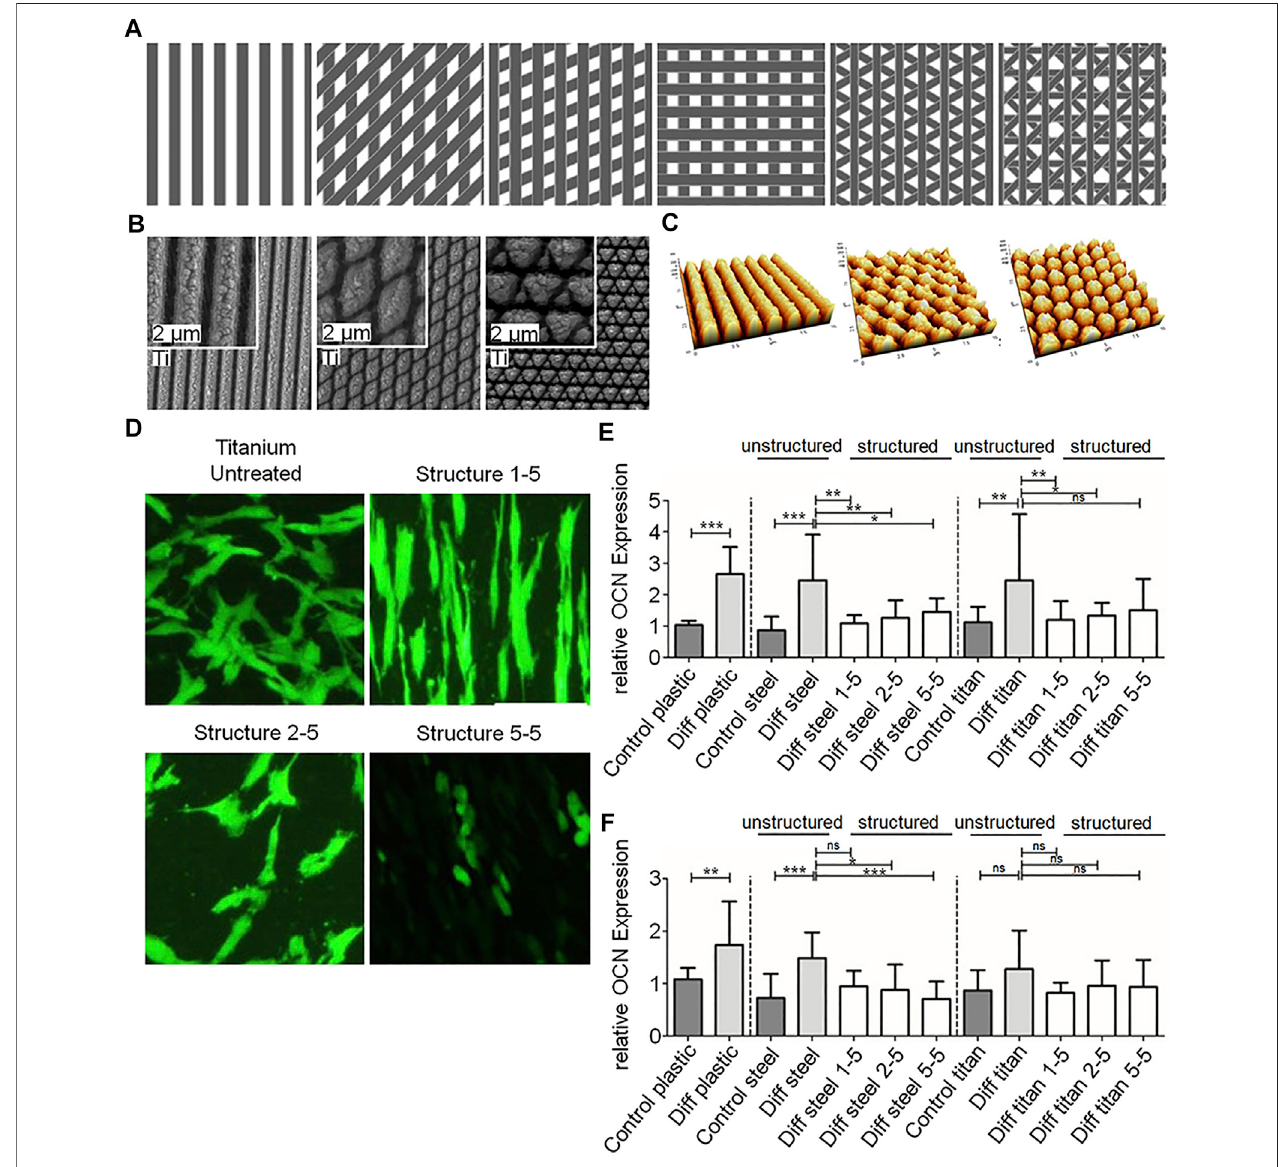
FIGURE 3| (A – C) Schematics, SEM images and AFM images of nano-scale textures with different patterns on laser ablated titanium. (D) Morphologies ofcells on different nano-scale textures. (E,F) Quantitative Results of OCN and RUNX2 expression in different groups. Reprinted with permission from (Boker et al., 2020).